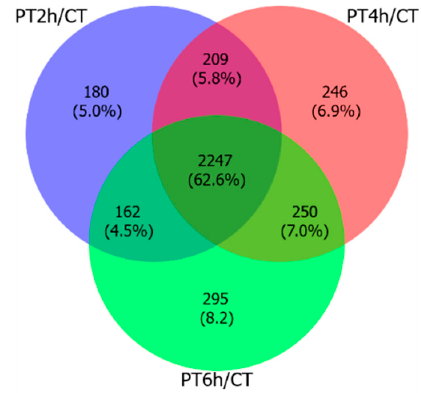
Figure 1. Venn diagram of differentially expressed genes (DEGs). This figure shows the number of common DEGs expressed in each PAE treatment group.